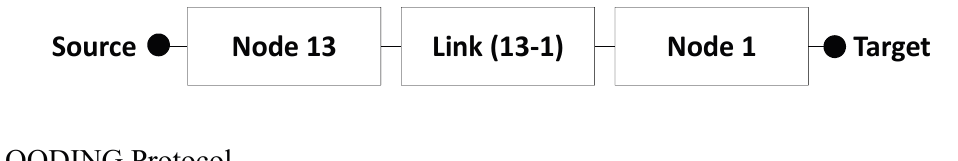
Figure 13. Region Model when the WSN uses the DIRECT protocol.